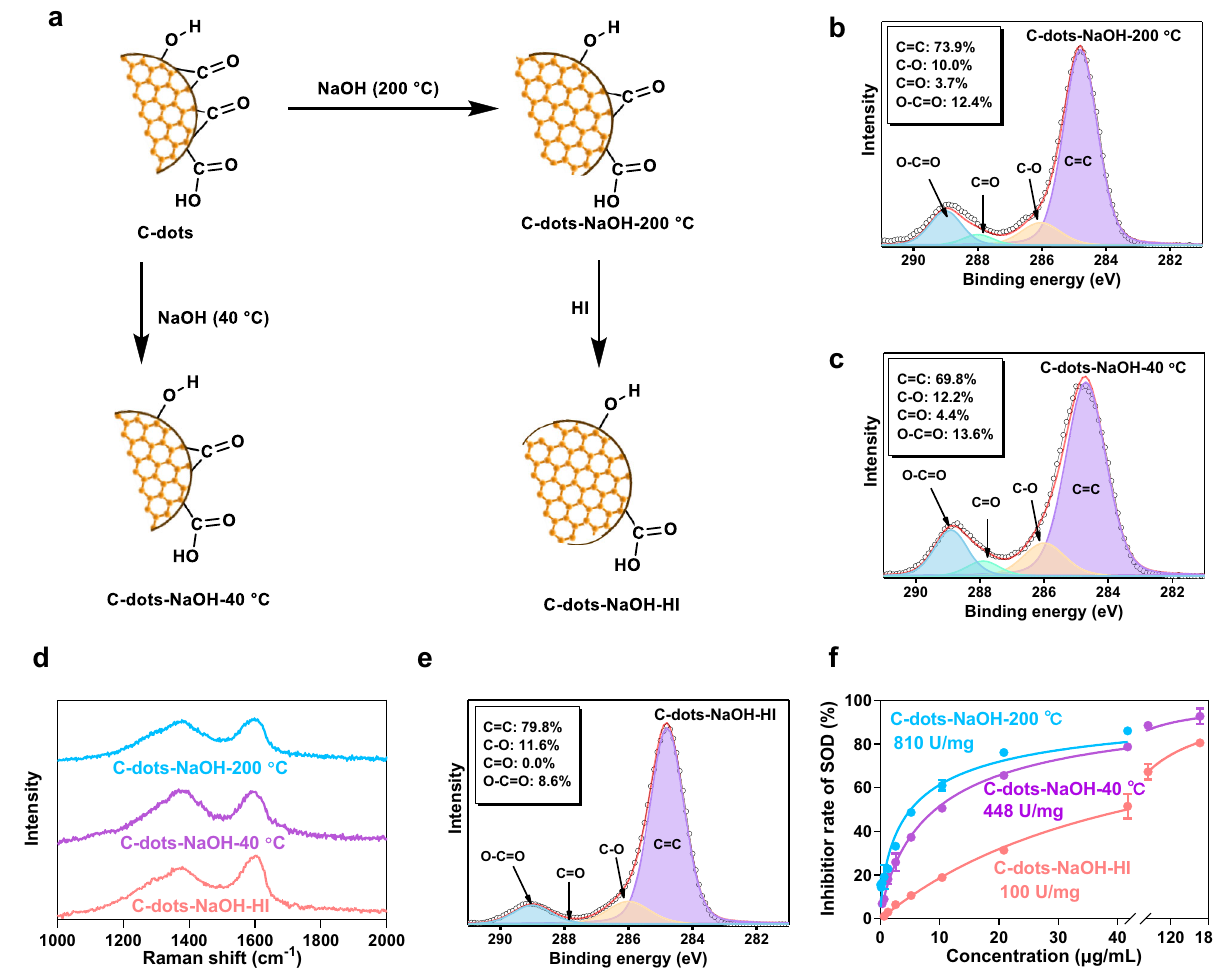
Fig.3|Surfacemodi fi cationstodeterminethecatalyticactivesiteofC-dotSOD nanozymes.a Illustrationof C-dots modi fi cation.C 1 s high-resolution XPSspectra with identi fi cation of peaks by curve fi tting of ( b ) C-dots-NaOH-200°C, ( c ) C-dots- NaOH-40 °C and ( e ) C-dots-NaOH-HI. d Raman spectra of C-dots-NaOH-200°C, C-